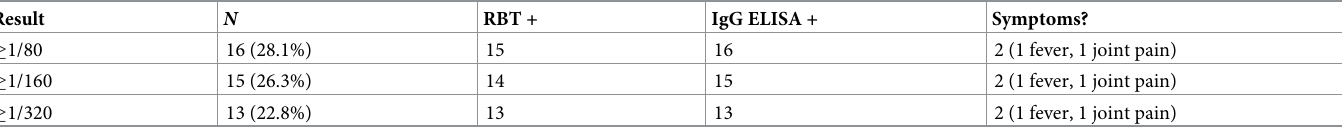
Table 7. SAT results of 57 persons in direct contact with large ruminants, classified as seropositive for Brucella spp. Result